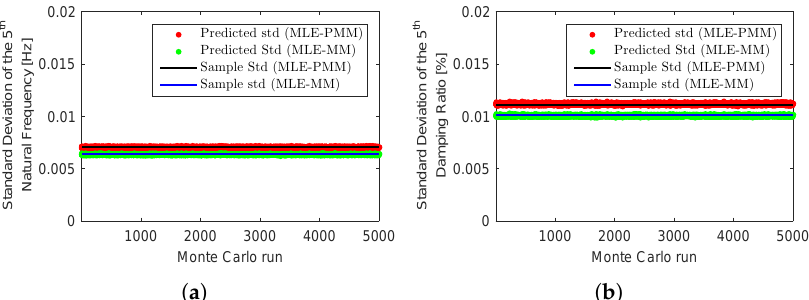
Figure 7. Monte Carlo simulation results for the five-DOF system example with 10% noise: sample standard deviation of the natural frequencies ( a ) and damping ratios ( b ) estimated for the 5th mode both with the MLE-PMM and MLE-MM [14] and their corresponding standard deviation estimates obtained after 10 iterations.